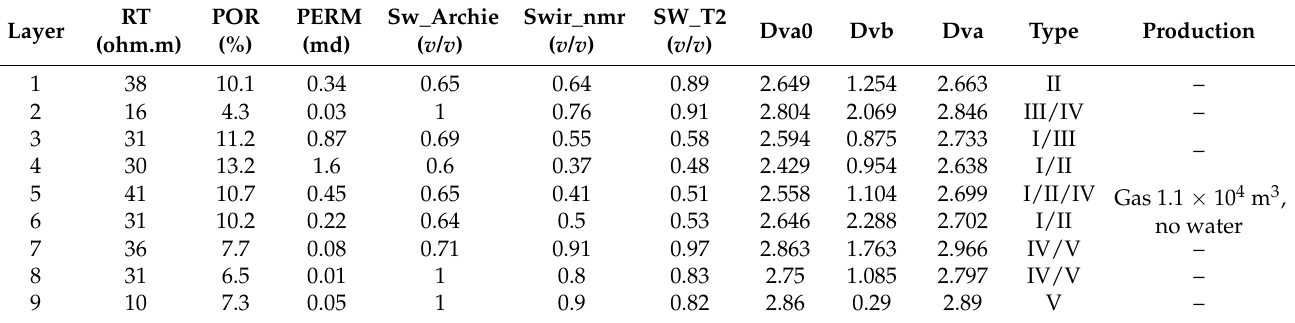
Table 3. Reservoir parameters of Layers